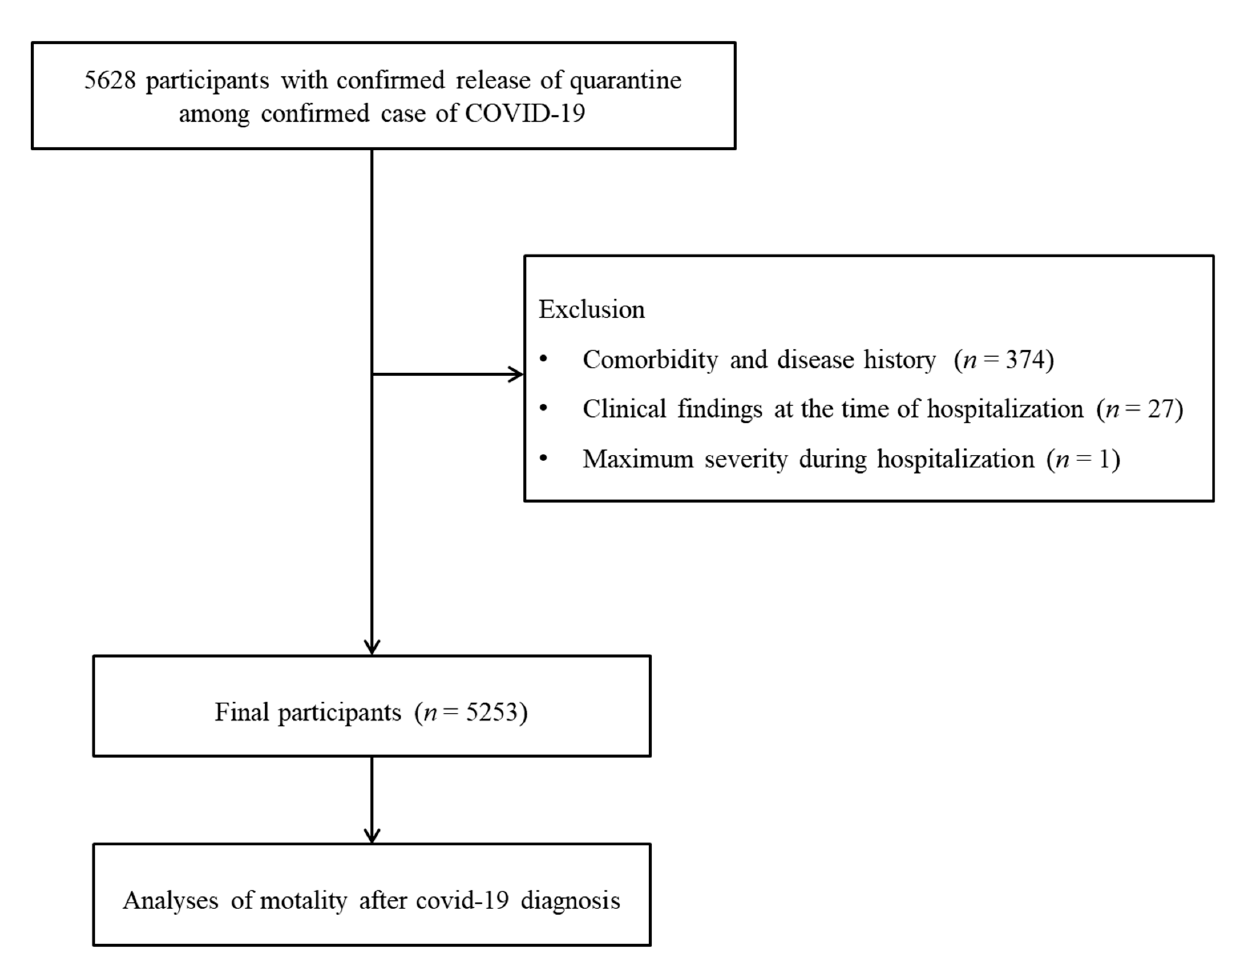
Figure 1. Schematic illustration of the participant selection process that was used in the present study. Of a total of 5628 confirmed COVID-19 patients, 5253 patients were enrolled.